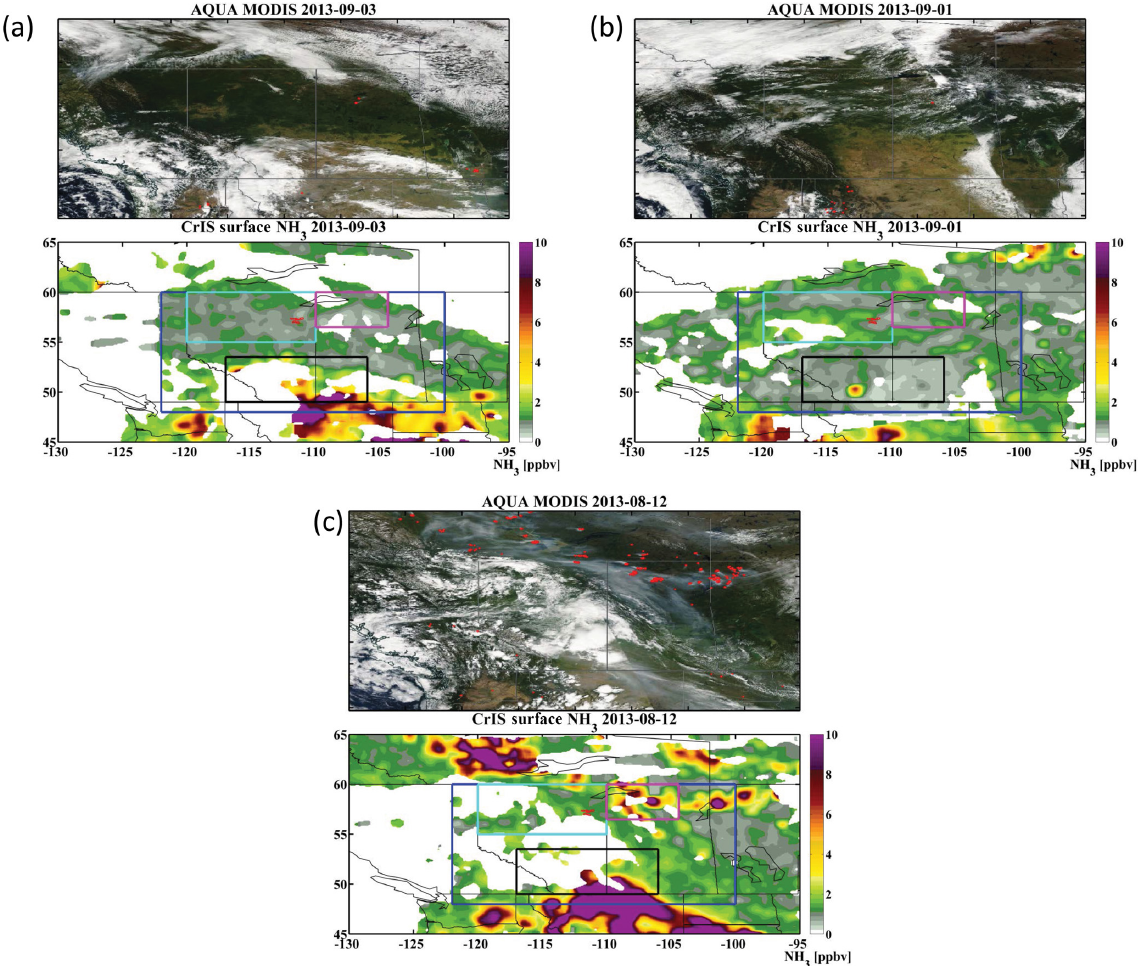
Figure 10. Images of the Alberta and Saskatchewan region with clouds and fire hotspots from MODIS (upper panels). Maps of CrIS-measured surface NH 3 VMRs, with coloured boxes showing the regions where model and satellite measurements were sampled (lower panels). These three examples are for (a) northern bidi case study (cyan), (b) southern bidi case study (black), and (c) fire case study (magenta), discussed in Sect. 4.3, and the blue box is the region of our overall